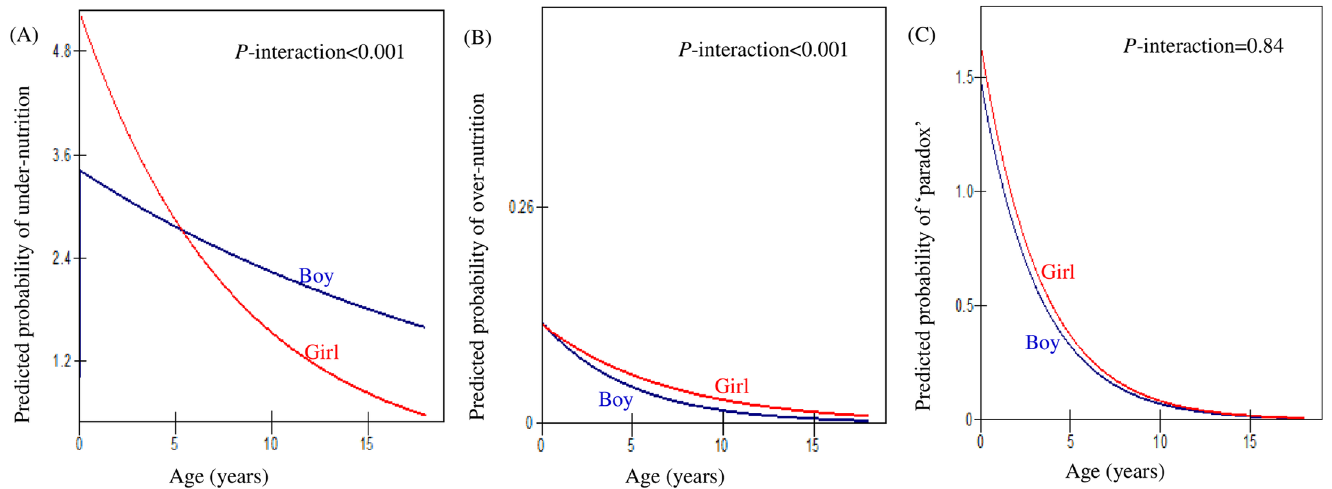
Fig 1. Predicted probability of (A) under-nutrition, (B) over-nutrition and (C) ‘ paradox ’ of malnutrition (stunted overweight) for rural children less than 18 years old by the interaction of age and gender, CHNS 1991 –